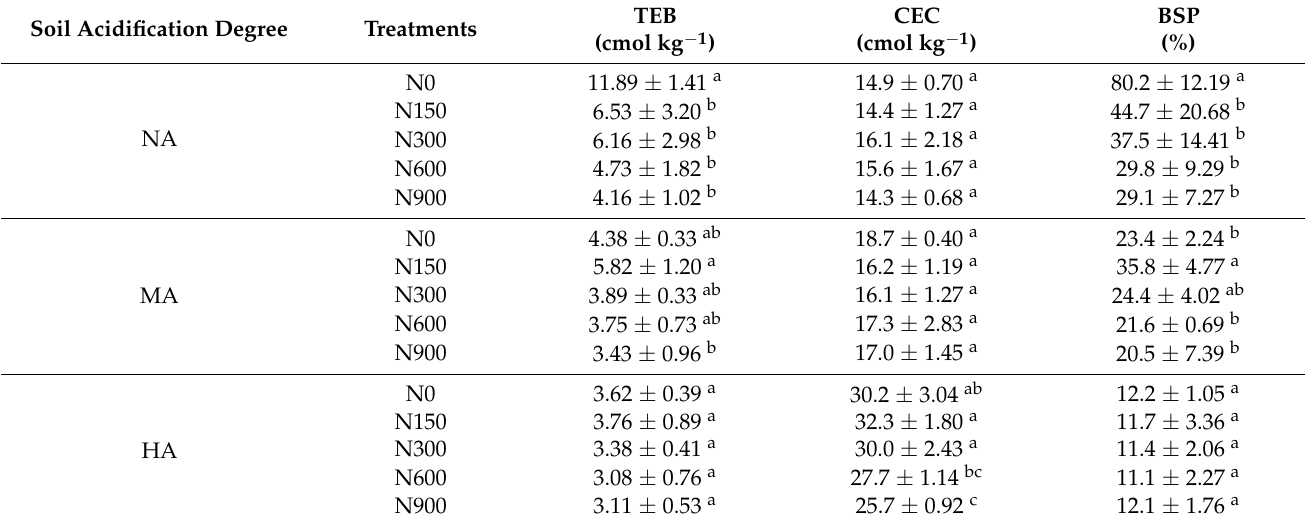
Table 6. Effects of N application rates on BSP at tea plantations with different degrees of acidification. Soil Acidification Degree Treatments